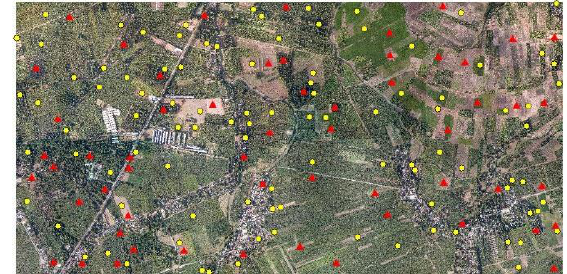
Figure 3. Training points used for classification are given as yellow dots while validation points are the red